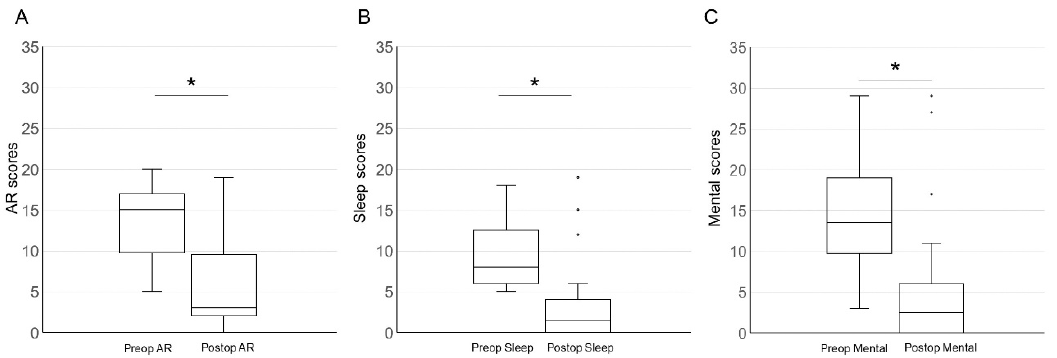
tween preoperative and postoperative scores for 1 item were 2.0 (95% CI: 1.5–2.5) for AR scores, 1.6 (95% CI: 1.3–1.9) for sleep scores, and 1.6 (95% CI: 1.3–2.0) for mental scores.